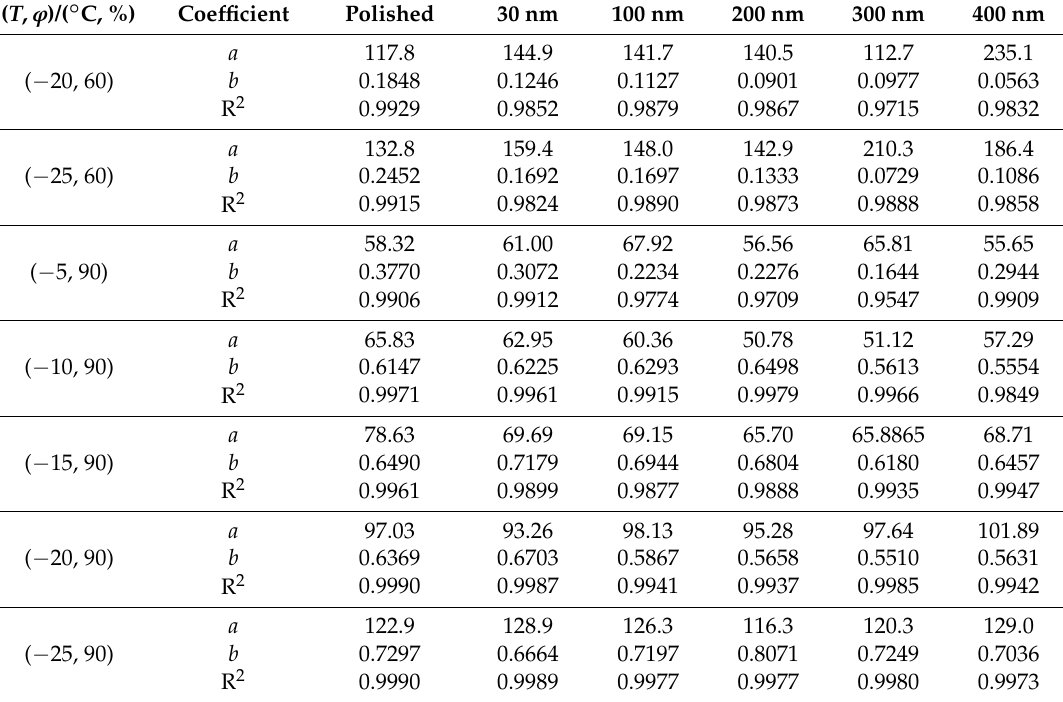
Table 6. Exponential model coefficients and regression formula